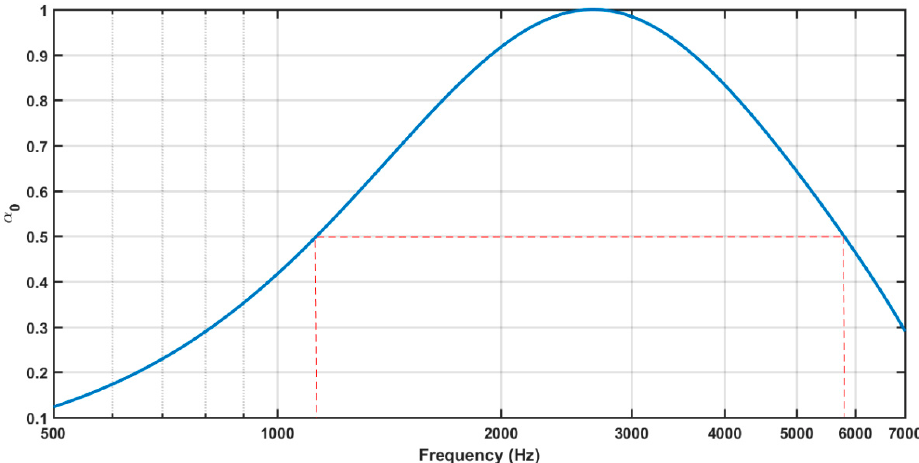
Figure 23. Normal incidence absorption coefficient of an SL-MPP with d = 0.12 mm, t = 1 mm, φ = 10%, and D = 2 cm.